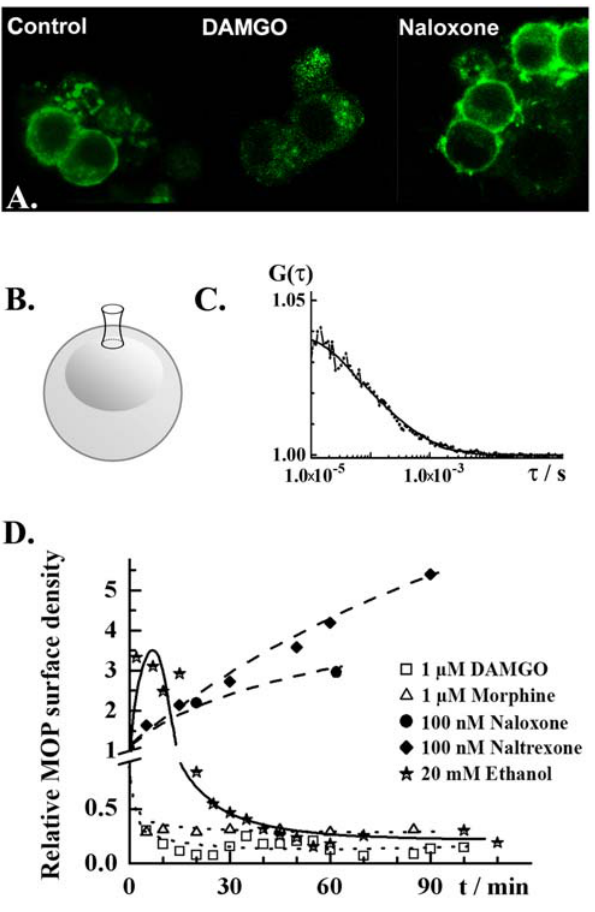
Figure 1. Effects of ethanol and opioid receptor agonists/ antagonists on the MOP surface density in live PC12 cells. A. Confocal fluorescence images showing subcellular localization of MOP- EGFP (green) in PC12 cells under control conditions (left), upon 3 h treatment with DAMGO (1.0 m M; middle) or naloxone (100 nM; right). EGFP fluorescence was excited using the 488 nm line of the Ar laser. Fluorescence emitted in the range 505–540 nm was collected. B. Schematic drawing of a PC12 cell, showing the location of the observation volume element during FCS measurements. FCS measure- ments were always performed on the apical side of the plasma membrane. C. Typical autocorrelation curve for MOP-EGFP in not stimulated PC12 cells. FCS measurements were performed and analyzed as described in the Materials and Methods section. The dots give the experimental autocorelation curve; the smooth curve is a theoretical autocorrelation curve derived using a two-component model for free 2D-diffusion (eq. 3). Two fractions of MOP-EGFP were identified that could be distinguished by differences in lateral mobility, t D1 =(250 6 150) m s and t D2 =(2.5 6 1.5) ms. The majority of MOP-EGFP was characterized by fast mobility, f 1 =(0.7 6 0.2). The amplitude of the autocorrelation curve is reciprocally proportional to the average number of MOP-EGFP molecules in the observation volume element (eq. 3). Autocorrelation curves are the basis for the calculation of relative changes in receptor surface densities as in the graph below. D . Relative changes in MOP-EGFP surface density under stimulation with selected drugs: ethanol (stars), naltrexone (diamonds), naloxone (dots), morphine (triangles) and DAMGO (squares). Selective ligands at MOP caused monotonous increase/decrease of MOP-EGFP surface density. Naloxone and naltrexone, acting as antagonists at MOP monotonously increased the MOP-EGFP surface density. The agonists DAMGO and morphine induced rapid internalization of MOP-EGFP, characterized by an internalization half-time t 1/2,agonists =2.5 min. Ethanol induced an abrupt transient increase in MOP-EGFP surface density, followed by partial internalization of MOP-EGFP, with an apparent internalization half-time of t 1/2,ethanol =25 min.